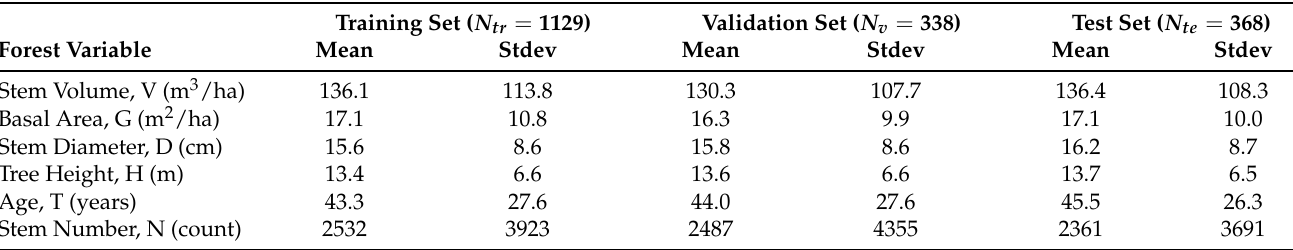
Table 4. Forest variable means and standard deviations (Stdev) for training, validation, and test data sets. N tr , N v , N te = Number of field plots in training, validation, and test sets,